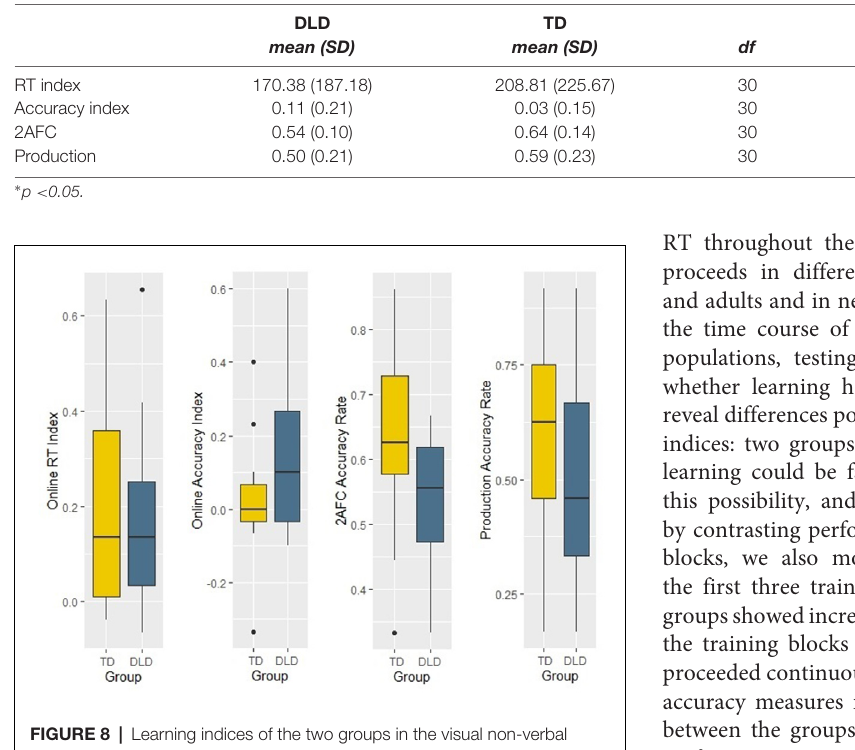
FIGURE 8 | Learning indices of the two groups in the visual non-verbal segmentation